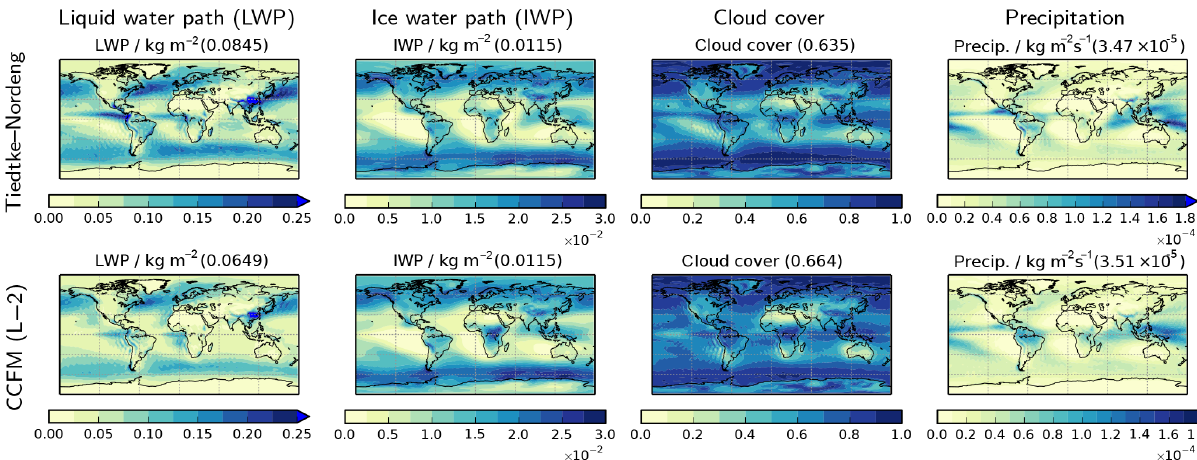
Figure 2. Annual mean (from left to right) liquid water path (LWP), ice water path (IWP), cloud cover and surface precipitation from 30-year AMIP-type simulations using ECHAM–HAM with Tiedtke–Nordeng and CCFM (L − 2) convection. The numbers in parentheses show the annual global mean of each quantity.